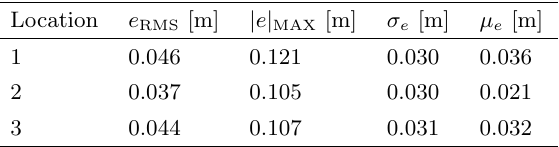
Table 1: Compensation